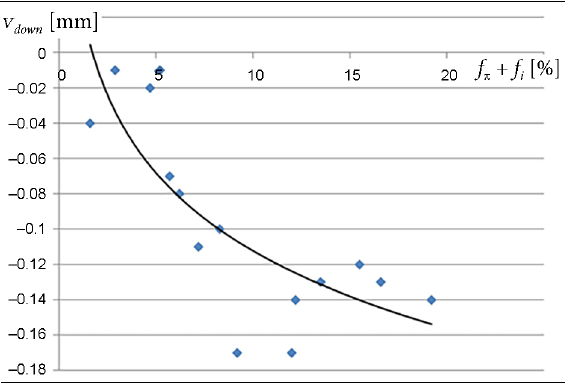
Figure 9. The dependence between maximum downward displacement of the annular surcharge rings and the content of fine fraction